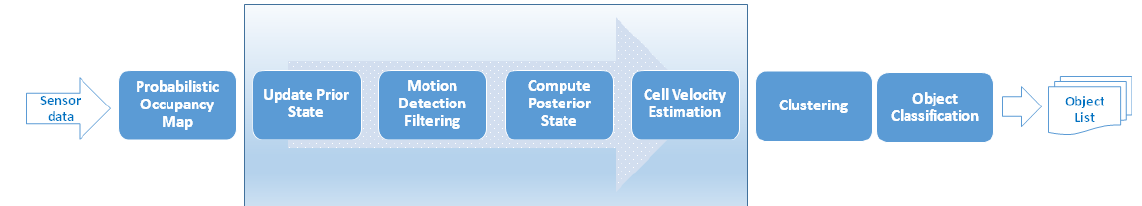
Figure 1. Bayesian Occupancy Filter process flow diagram and core system.